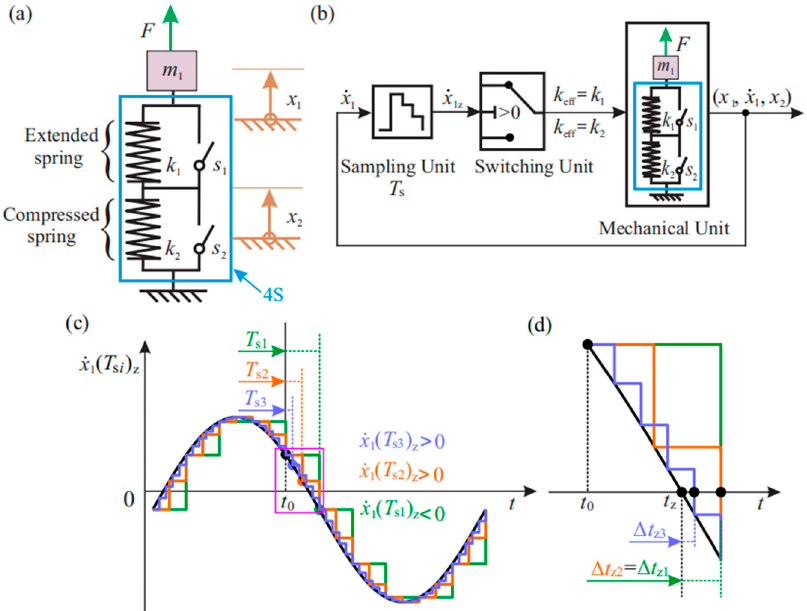
Figure 1. Schematic illustration of the 4S: ( a ) 4S with an attached load m 1 under force excitation F; ( b ) lumped controlled 4S; ( c , d ) switching determination error for the 4S with different sampling period T s . Black: original signal; green, orange and blue: discretized signals with different sampling periods T s1 , T s2 and T s3 ; ( d ) partly zoomed-in picture of ( c